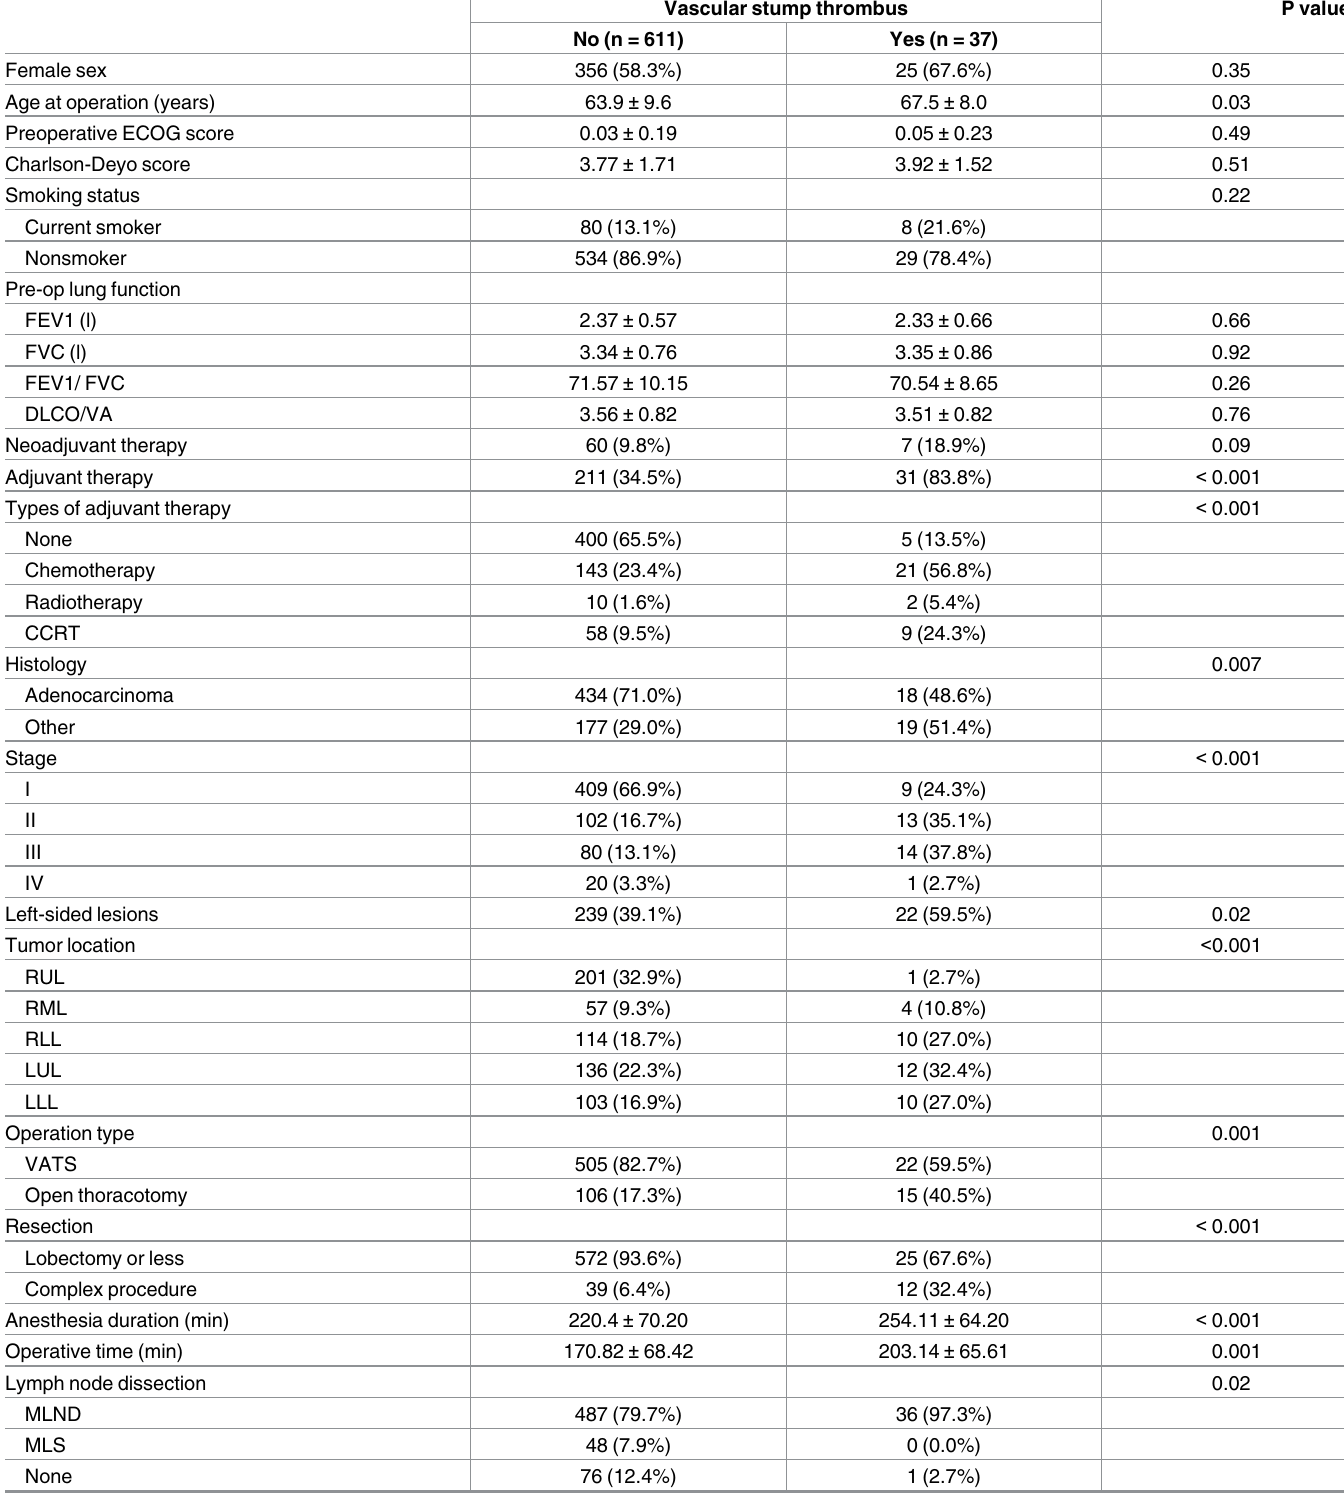
Table 1. Clinical characteristics of patients with and without vascularstump